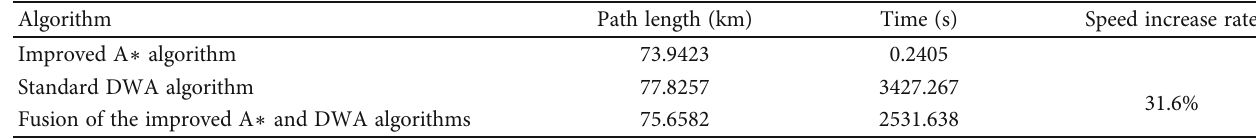
Table 1: Path planning results when the obstacles are known.